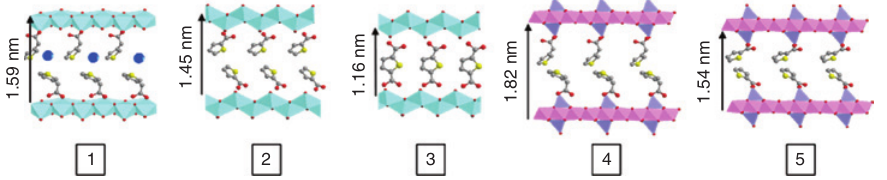
Figure 16: Schematic representations of the structures of hybrid compounds deduced from the structural, thermal, and spectroscopic analyses, based on the known structures of the parent compounds Cu (4), and (5) [83,